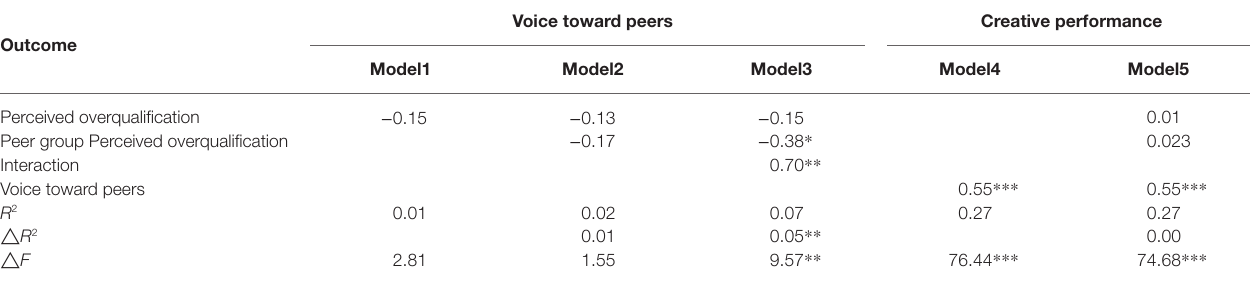
TABLE 3 | Results of regression